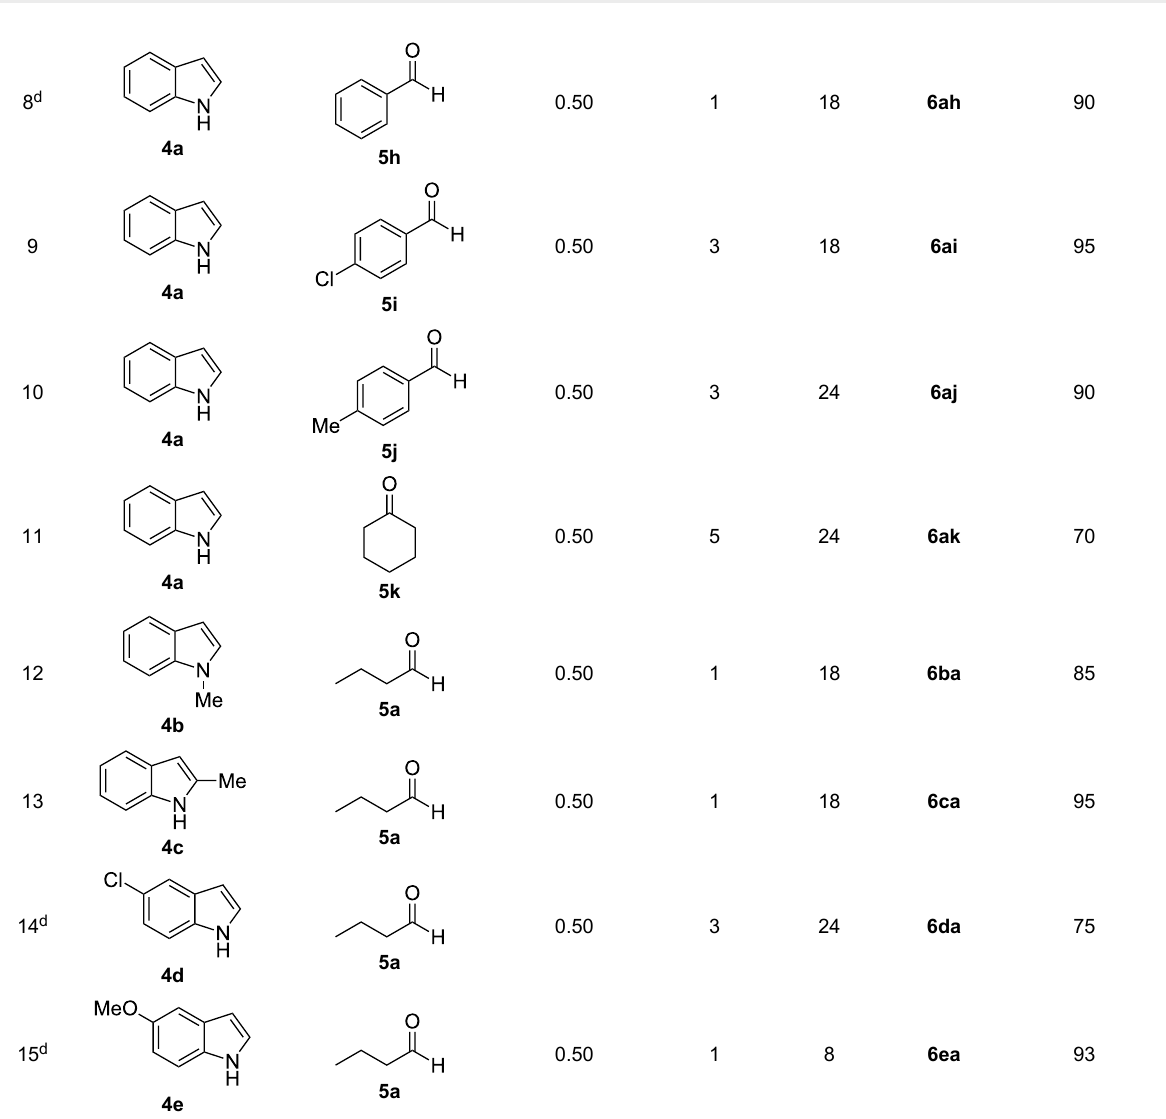
Table 2: Scope of the catalytic synthesis of BIM derivatives 6 . a